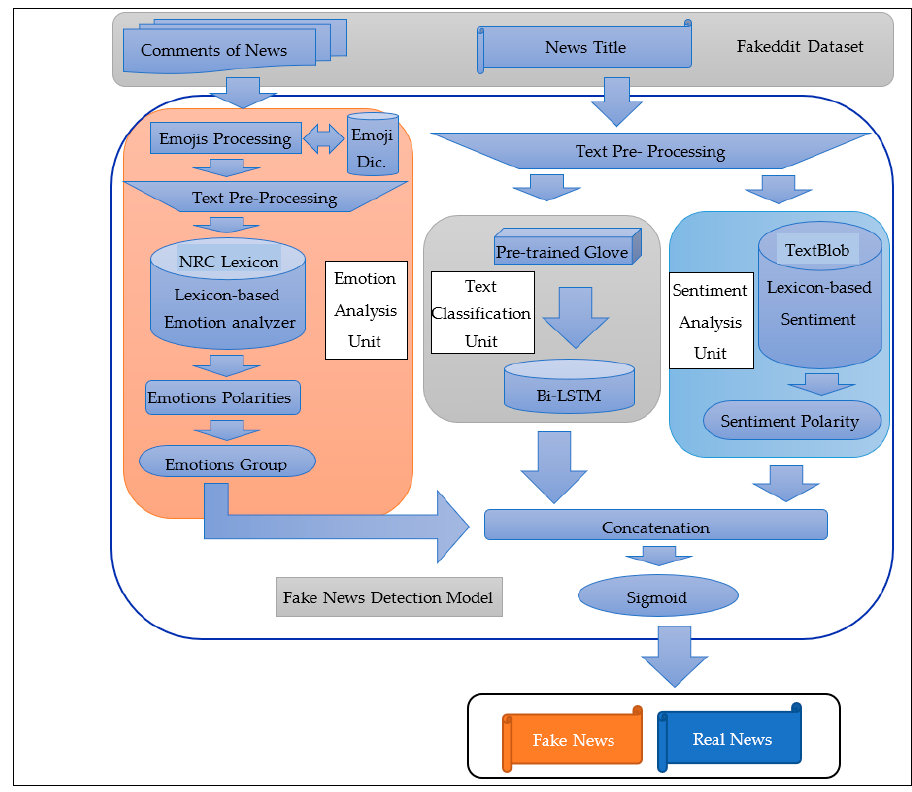
Figure 9. The general design of the proposed